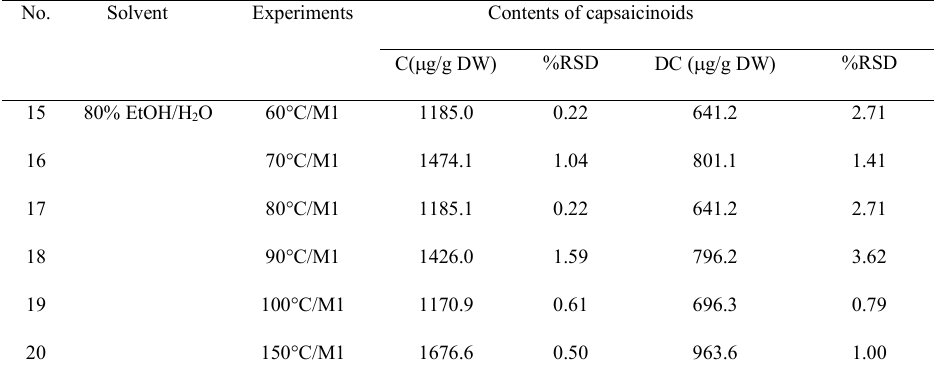
Table 2(b). Contents of capsaicinoids obtained from various conditions of ASE